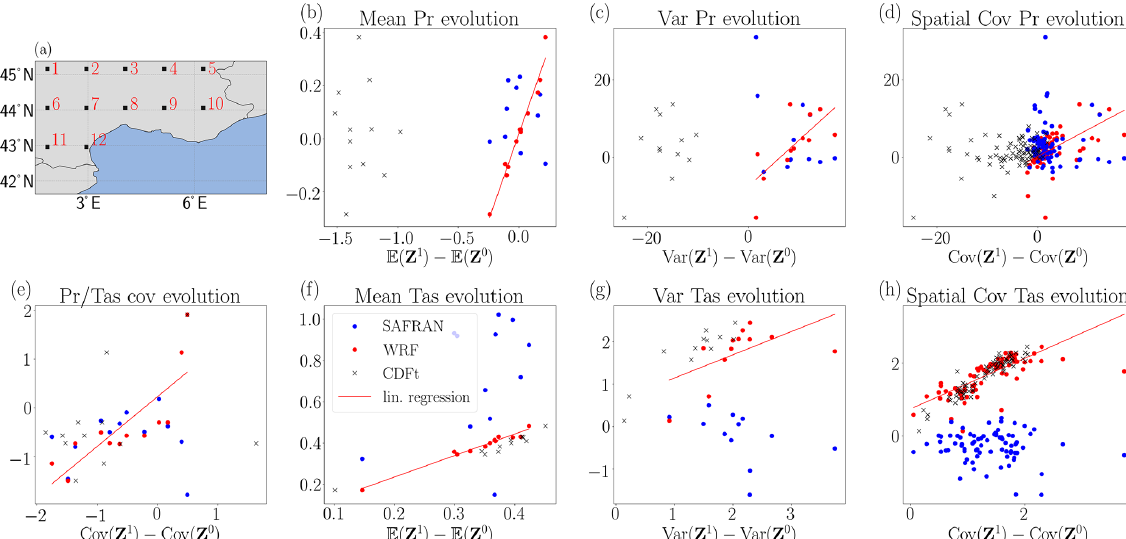
Figure 5. (a) Map of the southeast of France. The 12 black squares are the locations where corrections are performed. (b–h) The x axis of the panels is the evolution of the correction with dOTC. The y axis of panels (b) – (h) is the evolution of WRF in red and the evolution of SAFRAN in blue. The red line is the linear regression between the evolution of correction and the evolution of WRF. The black cross markers are the scatterplots between the evolution of correction with CDF- t and evolution of WRF. (b) Evolution of mean precipitation, i.e., difference between the projection period and the calibration period. (c) Evolution of variance of precipitation. (d) Evolution of spatial covariance of precipitation. (e) Evolution of covariance between precipitation and temperatures. (f) Evolution of mean temperatures. (g) Evolution of variance of temperatures. (h) Evolution of spatial covariance of